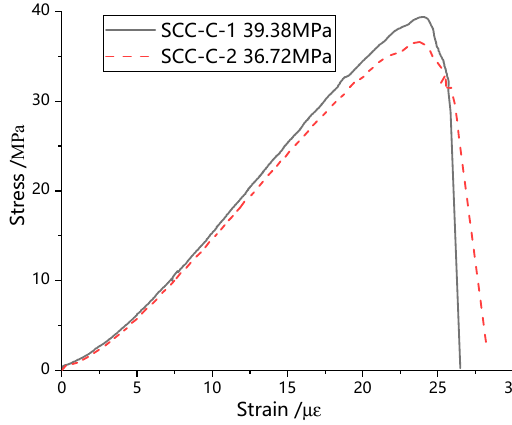
Figure 4. Uniaxial compression stress-strain curve of SCC.